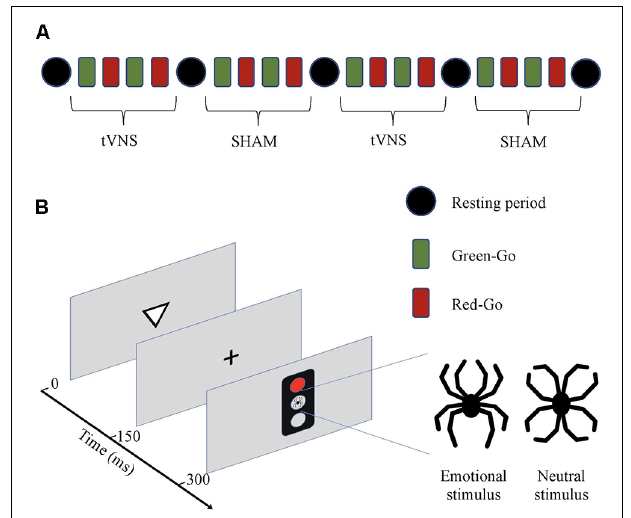
FIGURE 1 | (A) Schematic presentation of the experiment. The experiment consisted of two transcutaneous vagus nerve stimulation (tVNS) and two sham stimulation periods. Each period consisted of four blocks of trials with different response rules (Green-Go and Red-Go). Half of the subjects started with tVNS and the other half with sham stimulation. Stimulation type was alternated after every four blocks (10 min) and between different stimulation types, there was a resting period (4 min). (B) Executive RT-test (Hartikainen et al., 2010b). Subjects were required to respond to a visual stimulus, a triangle pointing up or down, by pressing as fast and as accurately as possible one of the two keys on a response pad according to the orientation of the previously presented triangle in a Go-condition or withhold from responding in a NoGo-condition. The orientation of the triangle was randomized within each block. Whether the subject was required to respond (Go) to or withhold from responding (NoGo), was indicated by a green or red traffic light. At the beginning of each block, there are instructions as to whether red color indicates a Go (Red-Go) and green a NoGo, or vice versa (Green-Go). The rule for responding changed after each block. A trial begins with a triangle pointing up or down for 150 ms followed by a fixation cross for another 150 ms. Subsequently, a traffic light appears for 150 ms. In the center of the traffic light, there was an emotional stimulus, a black line drawing resembling a spider, or an emotionally neutral control figure resembling a flower, both composed of identical line elements in a different configuration. Total error rate and mean RTs reflect the subject’s cognitive control in general and each error type a specific cognitive function with commission errors reflecting response inhibition, missing responses attention, and incorrect responses working memory,